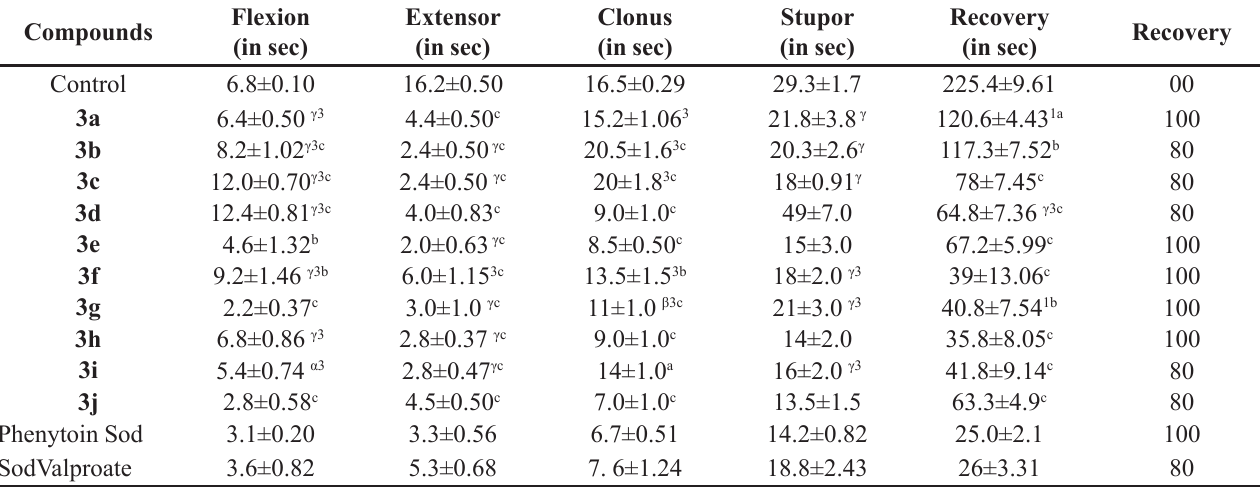
TABLE II - Anticonvulsant activities of 6-aryl-2-(imidazol-1-yl / 1,2,4-triazol-1-yl)-2-methyl-4,5- dihydro ( 2H )-pyridazin-3-one against maximum electro shock (MES) induced method Compounds